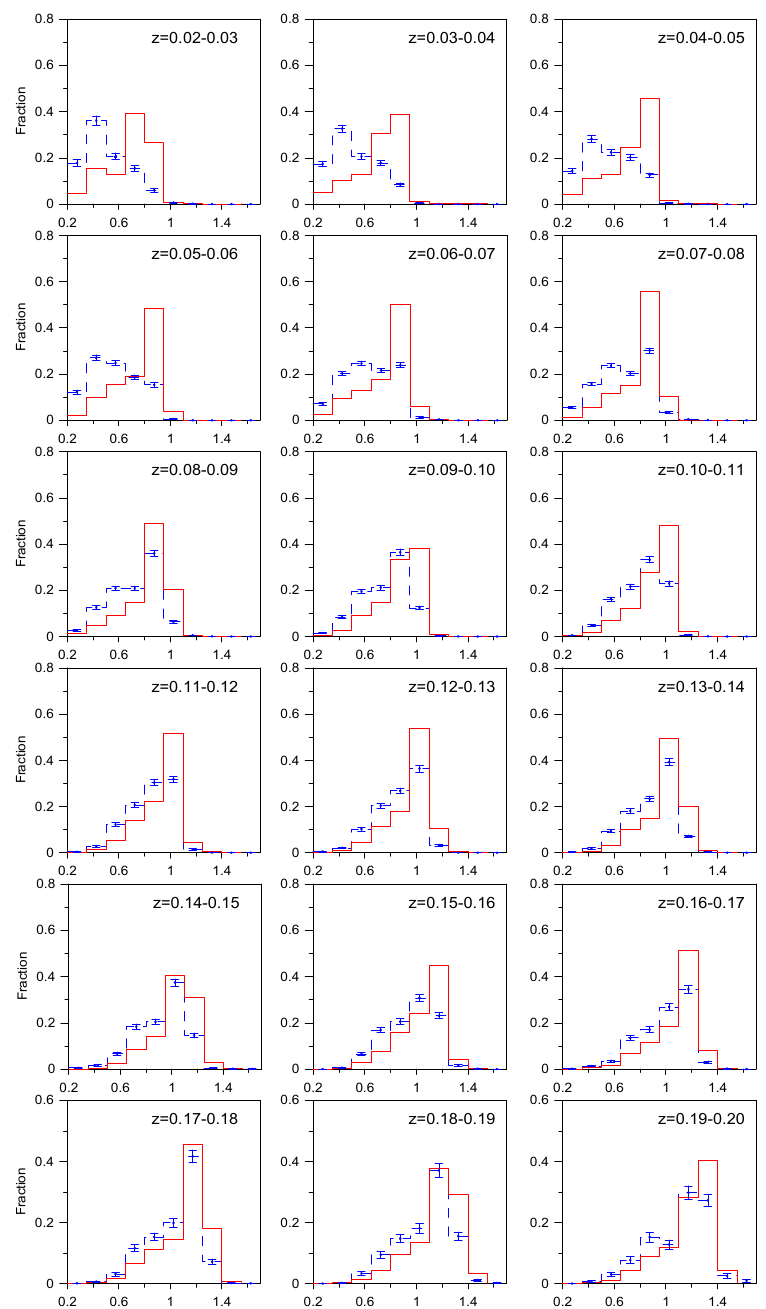
Fig. 3. Distribution of g – r colors. Designations are the same as in Figure